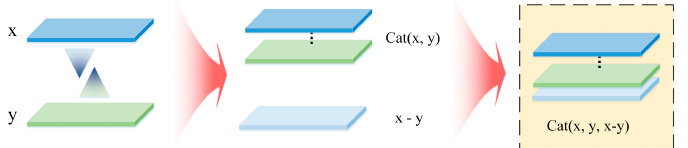
Figure 6. Our Multi-Level Cost Volume. For the original information, there is a limit to the distribu- tion method of retaining and removing. Through the experiment in the following chapters, we chose the construction form in the yellow box on the right of the figure to build a multi-level cost volume by combining the original x and y features and the differential fusion.